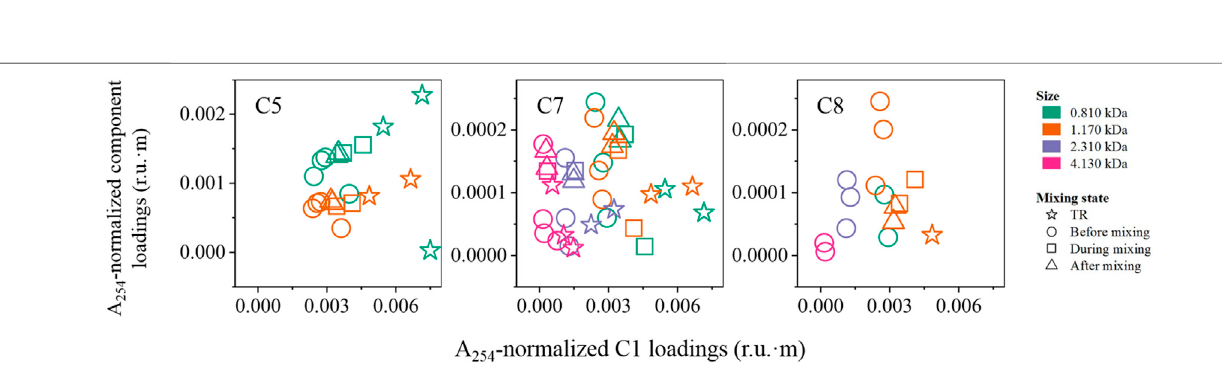
Frontiers in Environmental Chemistry |